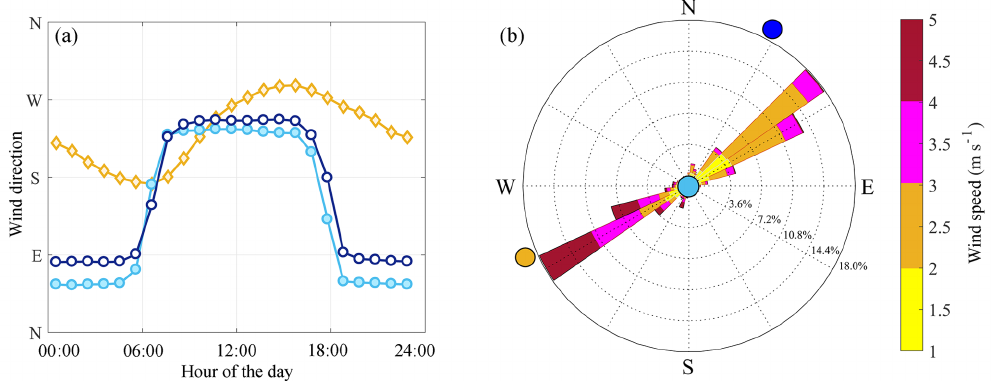
Figure 2. Hourly mean wind directions in Visalia (orange diamonds), SEQ1 (cyan filled circles), and SEQ2 (dark blue open circles) in April–October 2001–2012 (a) . Wind rose for SEQ1 (b) with the direction of the neighboring sites of Visalia (orange), SEQ1 (cyan), and SEQ2 (dark blue) indicated.